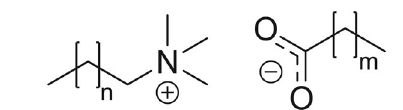
Figure 1. N -alkyl- N , N , N -trimethylammonium